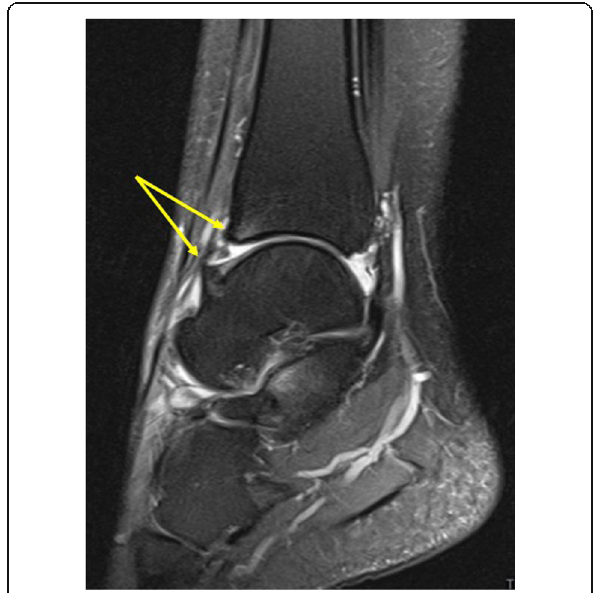
Fig. 19 A 22-year-old soccer player presented with chronic anterior ankle pain. There was no history of specific ankle trauma leading to suspicion of anterior impingement. MRI showed anterior impingement with osteophytes (arrows) and bone marrow edema